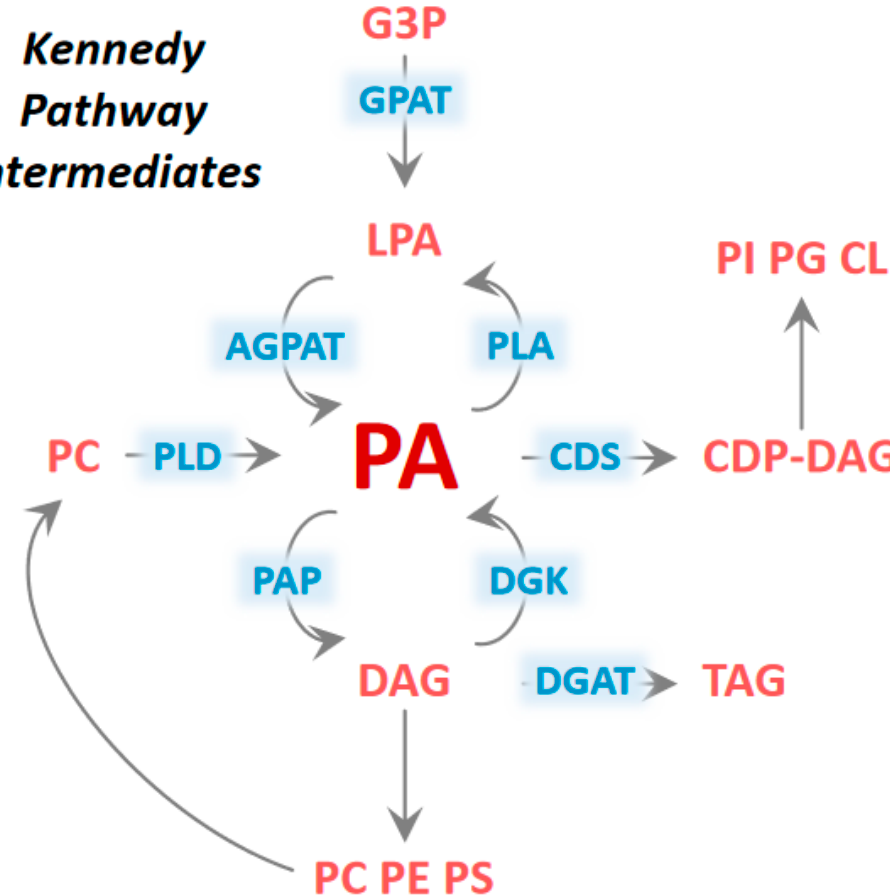
Figure 1. Phosphatidic acid as a central component in the Kennedy Pathway of lipid synthesis. Phosphatidic acid (PA) can be synthesized from and converted to numerus glycerophospholipids involved in membrane formation, cell signaling, lipid storage, and many others. Enzyme abbreviations in blue: glycerol-3-phosphate acyltransferase (GPAT), 1-acylglycerol-3-phosphate O-acyltransferase (AGPAT), phospholipase A (PLA), phospholipase D (PLD), cytidine diphosphate diacylglycerol Synthase (CDS), diacylglycerol kinase (DGK), phosphatidic acid phosphatase (PAP), diacylglycerol O-acyltransferase (DGAT). Glycerophospholipids and derivatives abbreviations in red: glycerol-3-phosphate (G3P), lysophosphatidic acid (LPA), phosphatidic acid (PA), phosphatidylcholine (PC), cytidine diphosphate diacylglycerol (CDP-DAG), phosphatidylinositol (PI), phosphatidylglycerol (PG), cardiolipin (CL), diacylglycerol (DAG), triacylglycerol (TAG), phosphatidylcholine (PC), phosphatidylethanolamine (PE), phosphatidylserine (PS).